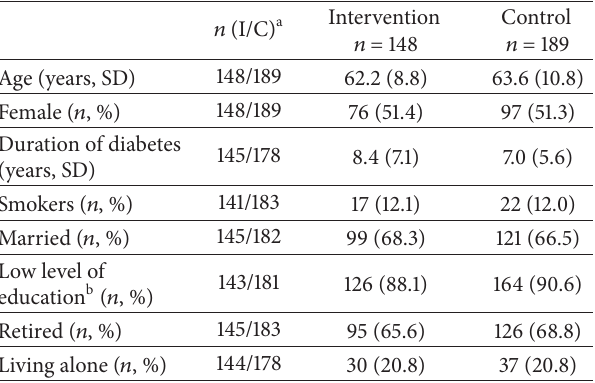
Table 2: Baseline characteristics of